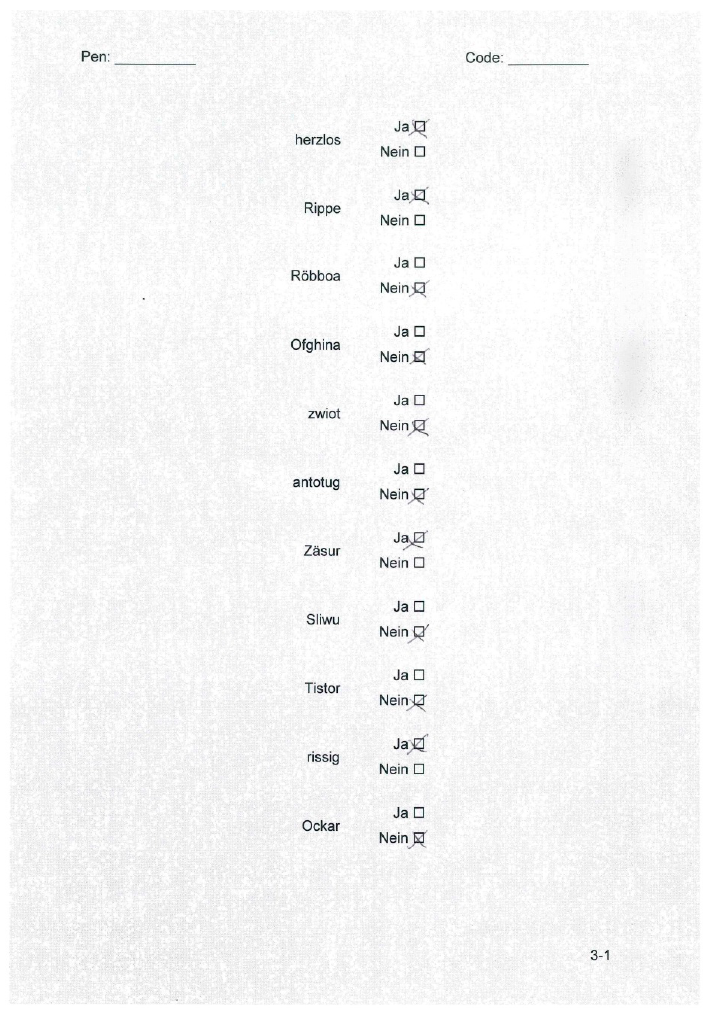
Figure A1. Illustration of one page of the lexical decision task.